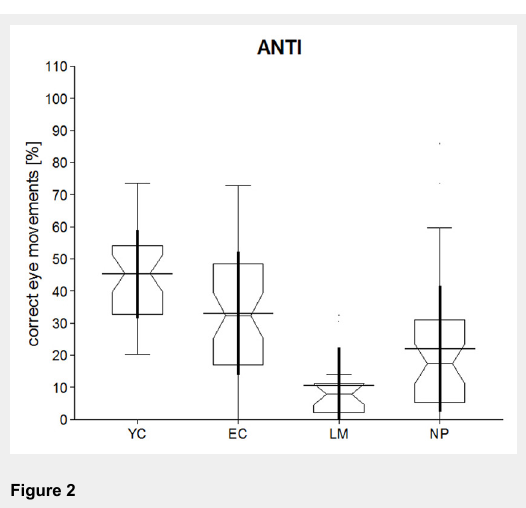
Evaluation of all antisaccades for all groups. EC = elderly comparison group; LM = patients at the Department of Legal Medicine; NP = patients at the Department of Neurology; YC = young comparison group